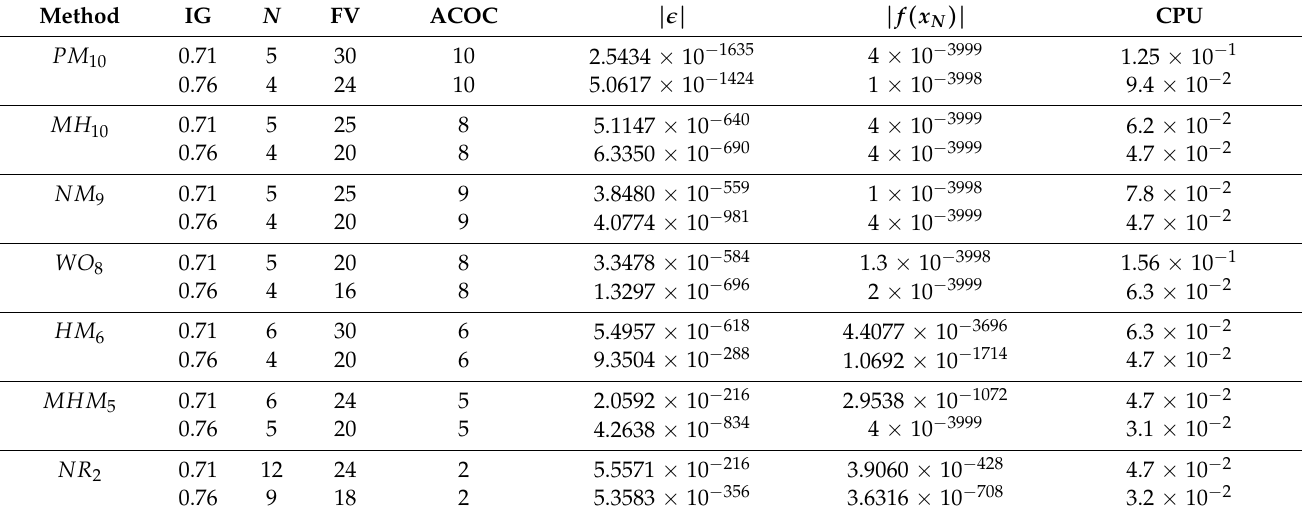
Table 10. Numerical results for problem